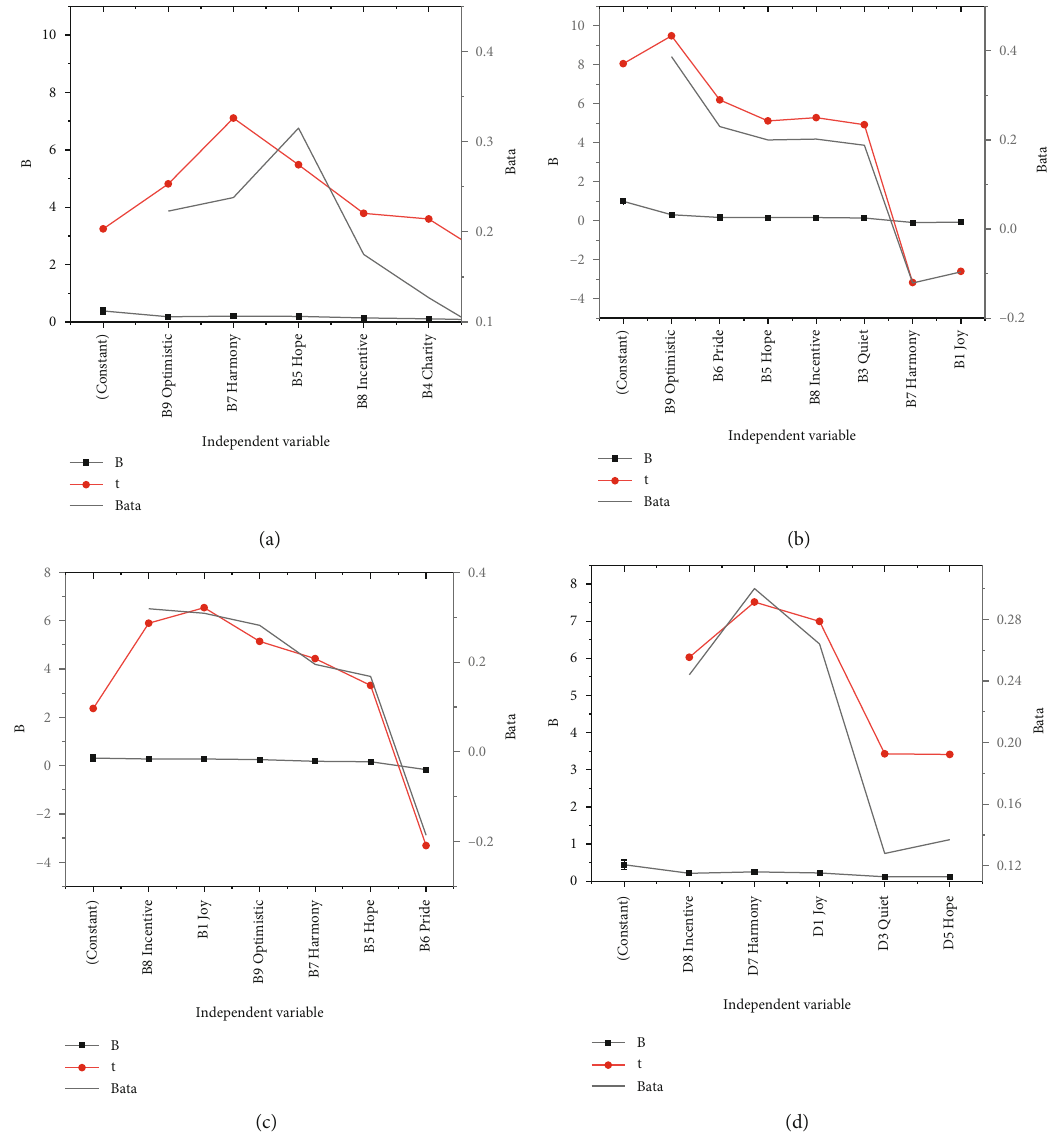
Figure 11: QS results in the enhancement e ff ects of di ff erent music styles on positive emotions around the world ((a) “ Someone Like You ” ; (b) “ Electronic Synthetic Music ” ; (c) “ Suddenly ” ; (d) “ Dhyana ” ; B is the nonstandardized coe ffi cient; t represents the emotional